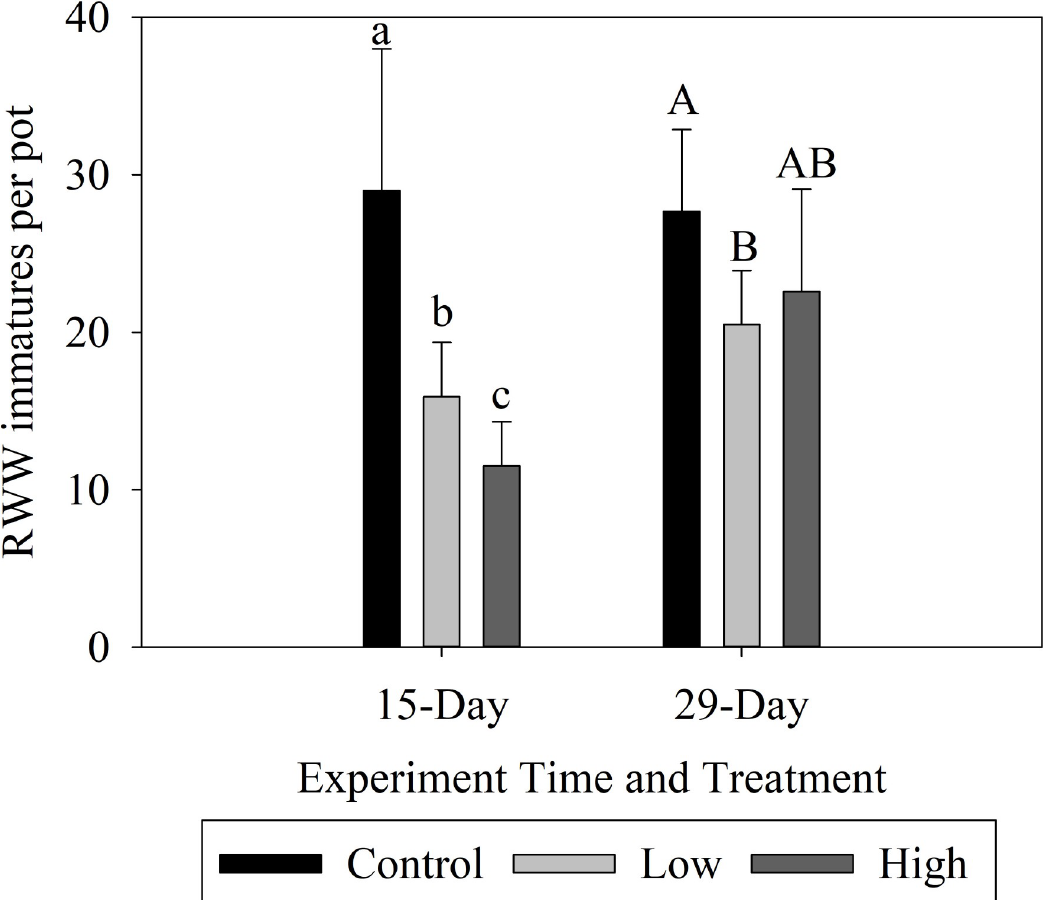
Fig 1. Effect of seed treatment with methyl jasmonate at three concentrations on counts of first instars emerging from plants (larvae per pot ± S.E.) in a greenhouse experiment performed in 2018. Plants were infested with adult RWW 15 days and 29 days after treatment of seeds. Bars accompanied by different letters represent means that differed significantly by Tukey’s HSD test at α < .05.